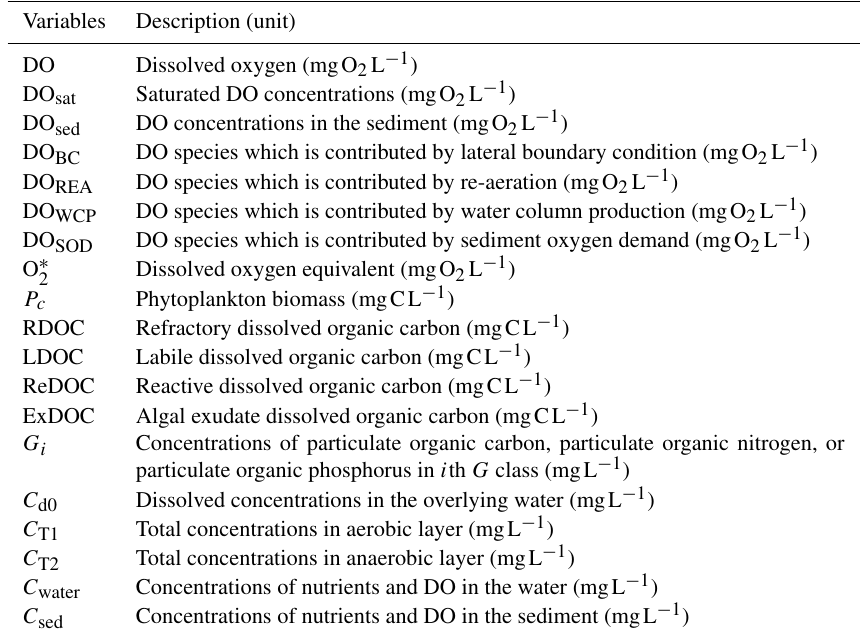
Table A1. List of state variables in the water quality model (RCA) and the DO species-tracing method. Variables